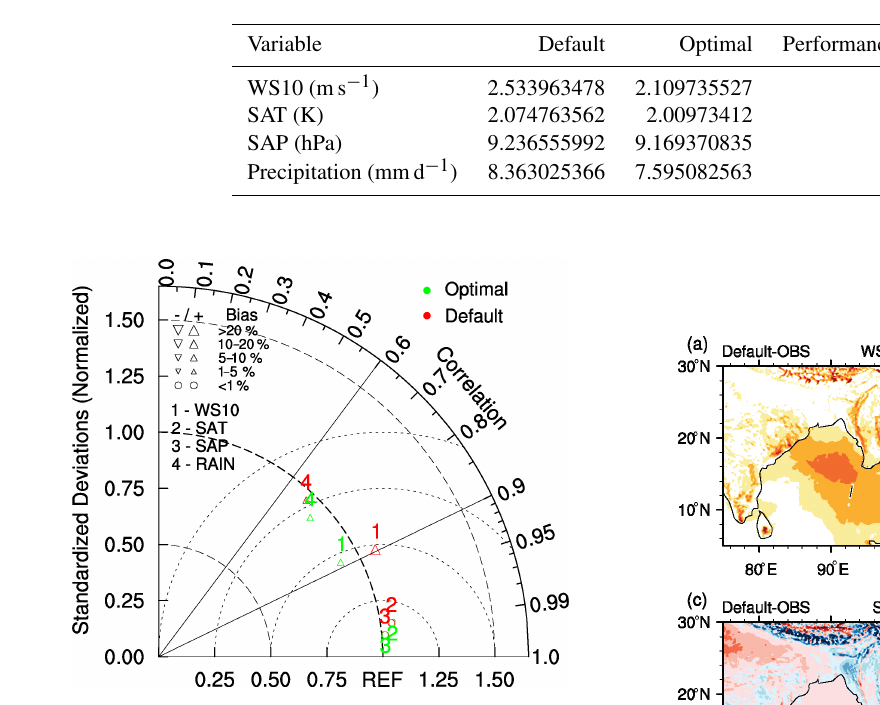
Figure 14. Comparison of Taylor statistics of WS10, SAT, SAP, and RAIN, simulated using the default and optimal parameters, av- eraged over all the cyclones for 3.5d.